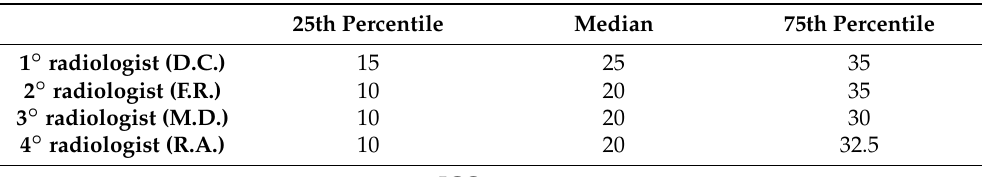
Table 2. Summary of descriptive statistical calculation obtained from the four radiologists. This table shows good reliability among the four radiologists, as underlined by the good ICC score (0.79). ICC = Intraclass Correlation Coefficient.